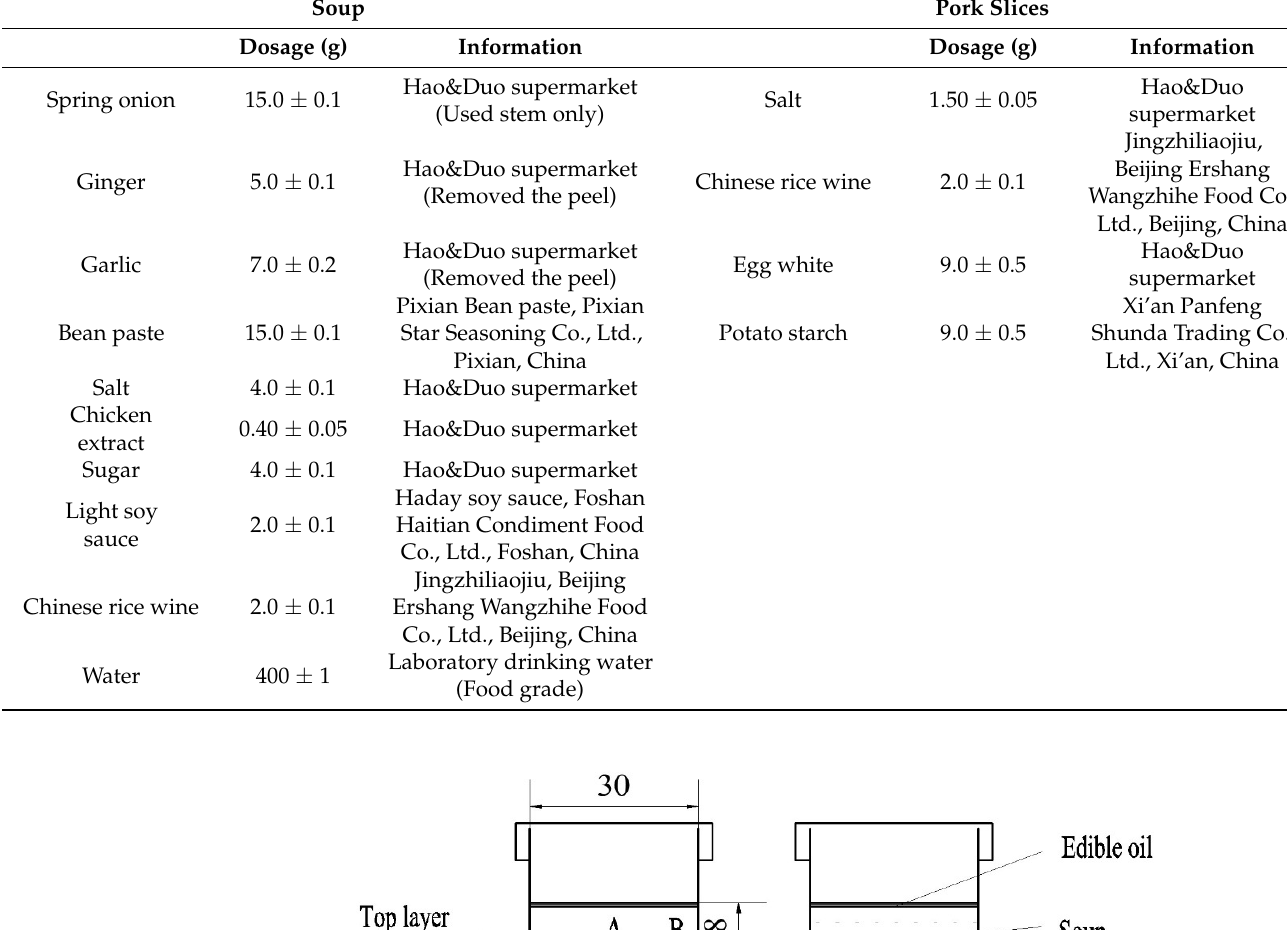
Table 1. Materials and dosage involved in PSPS cooking (listed in the order of use).